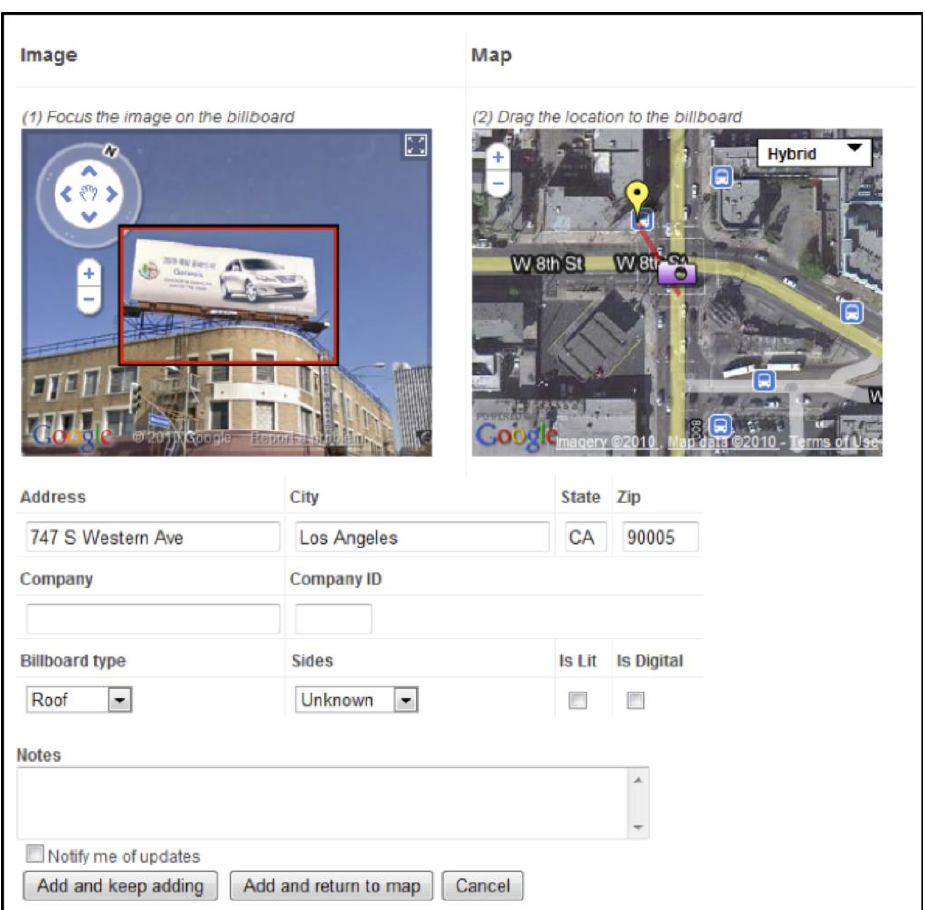
Figure 2. The Billboard Map's pop-up window for data collection, featuring a Google Street View window, a map win- dow, and fields for attribute